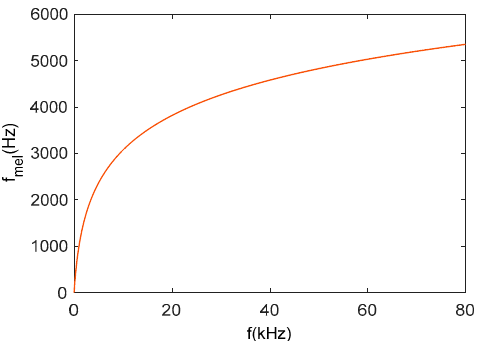
Figure 1. Graph indicating the relationship between mel frequency and actual frequency directly.